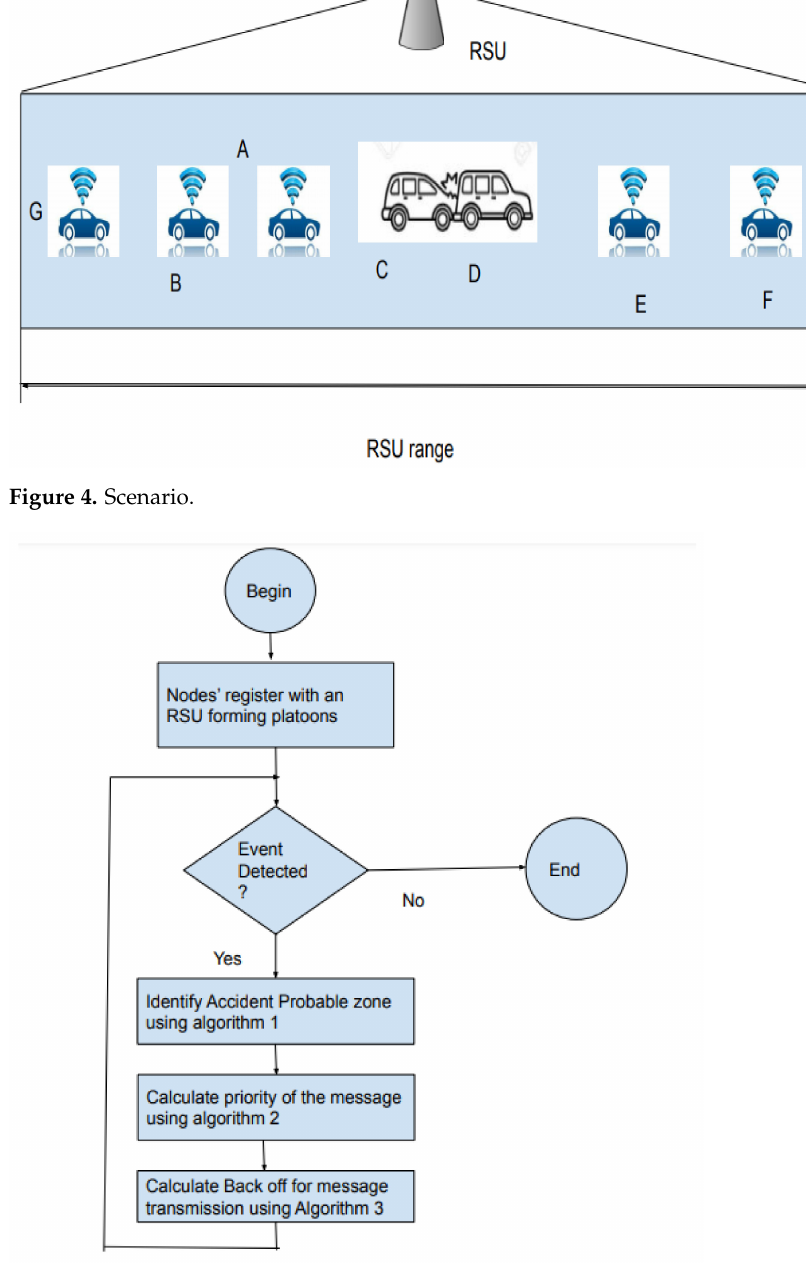
Figure 5. Overview of the proposed priority-based cooperative MAC (PCMAC) protocol. The RSU (road-side unit) in the scenario communicates with the vehicles and frames to the vehicles at periodic intervals. The time frame used in the protocol is shown in Figure 6. During the first phase, RSU will broadcast the details of the registered vehicles to the platoon. It includes the vehicle IDs, the number of vehicles registered in range, and the average velocity of the platoon. The protocol needs to provide the nodes with access to the channel for the transmitting of both beacon and event messages. In the control channel, the nodes will first listen to the road-side unit. In the second phase, PCMAC follows a random-access mechanism that selects a back-off value from the contention window depending on the priority of the packet at that instant. The flow of execution of the protocol is as shown in Figure